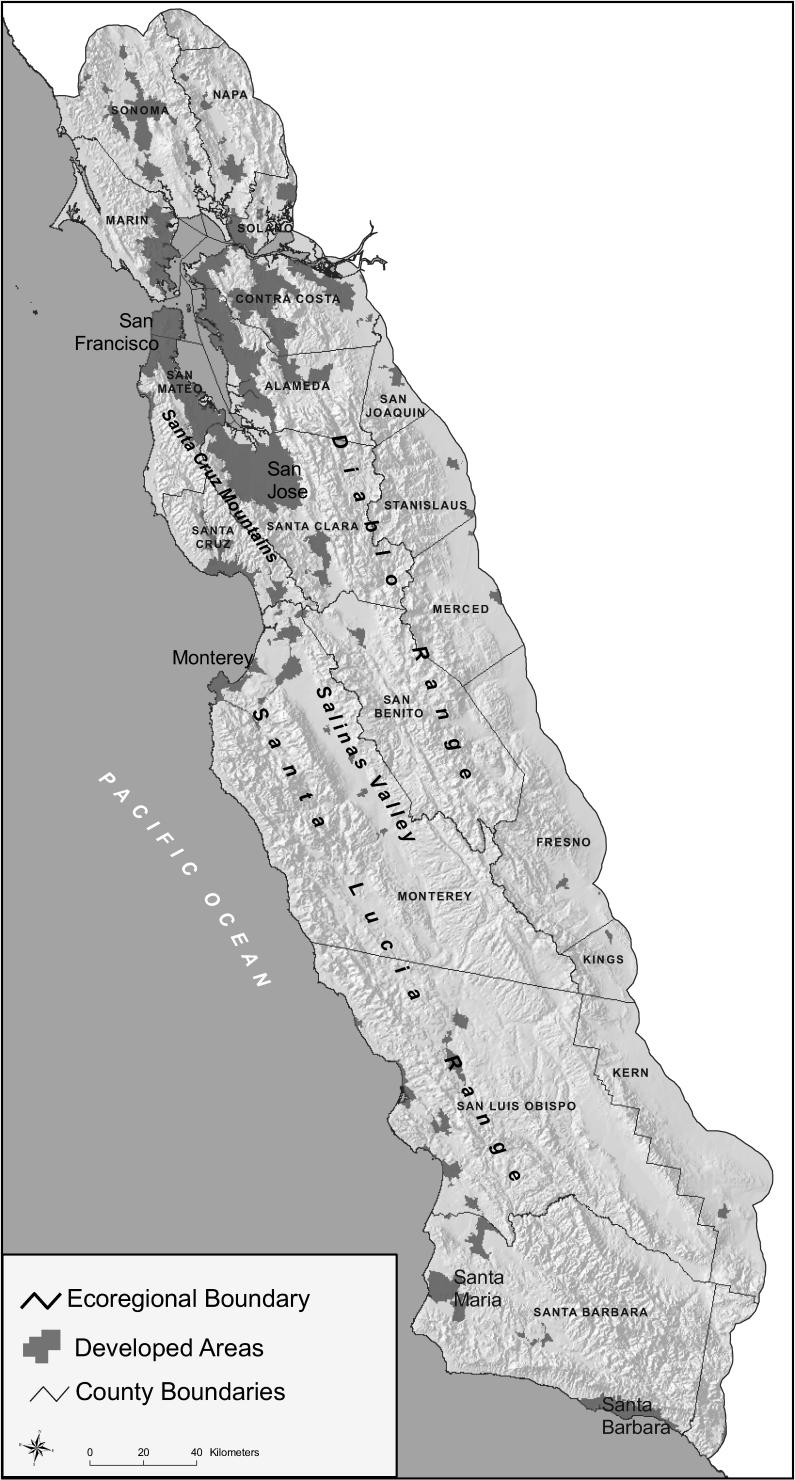
The Central Coast Ecoregion of California, with Geographic Features Mentioned in the Text